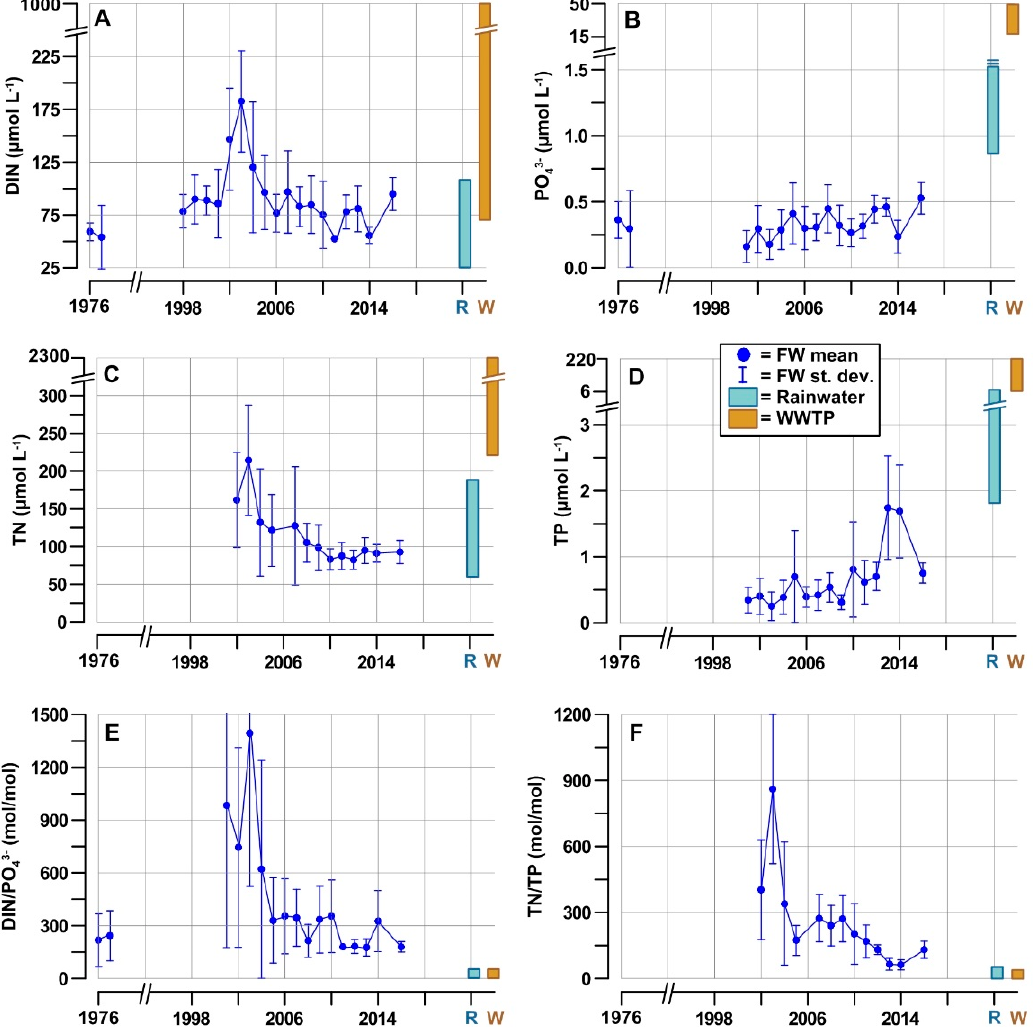
Figure 6. Mean concentrations (µmol L − 1 ) of dissolved inorganic nitrogen ( A ), phosphate ( B ), total nitrogen ( C ) and total phosphorus ( D ) and ratios (mol/mol) of DIN/PO 43 − ( E ) and TN/TP ( F ) in Isonzo River water (FW), in comparison to typical ranges of nutrient concentration in rainwater (R) and in the wastewaters (W) discharged in the GoT (data are shown in the Tables